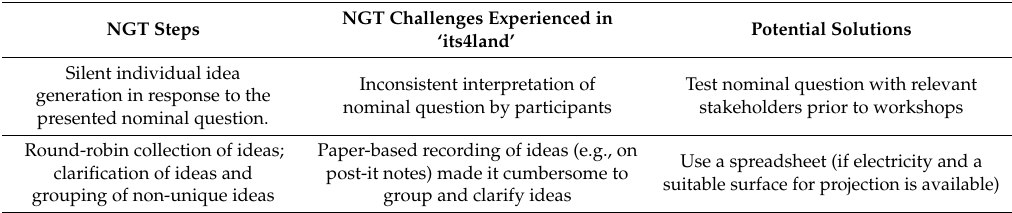
Table 6. Overview of challenge of using NGT as a method for needs assessment in the its4land project and potential